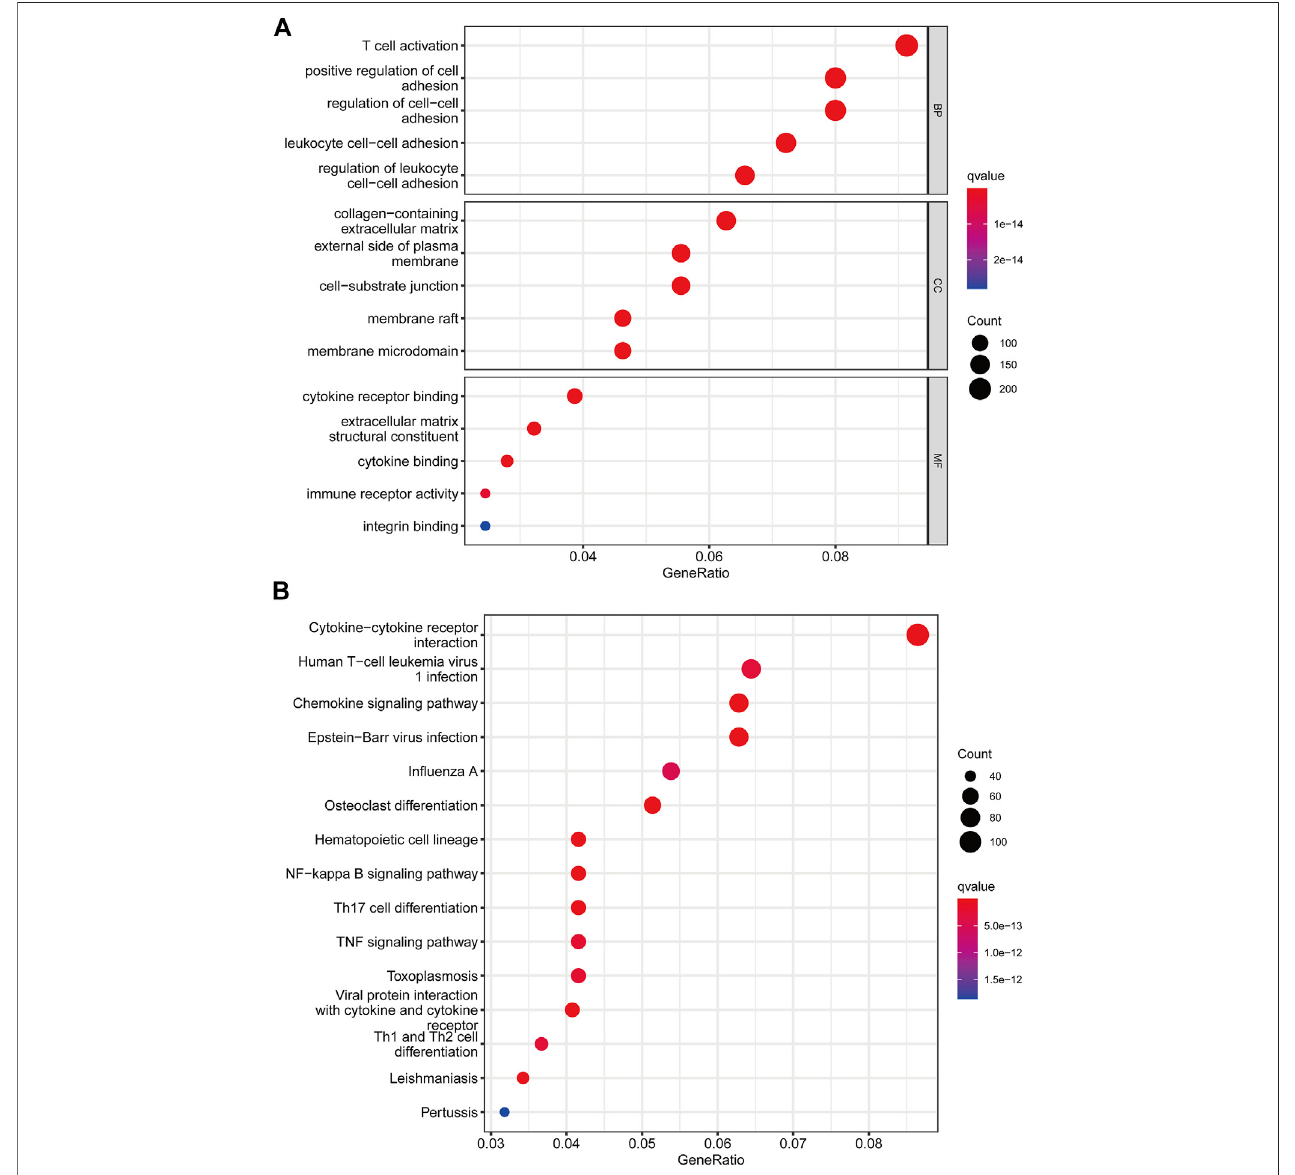
FIGURE 4 | Functional enrichment analysis among two pyroptosis subtypes. (A) Enrichment of GO functions. (B) The KEGG pathway.